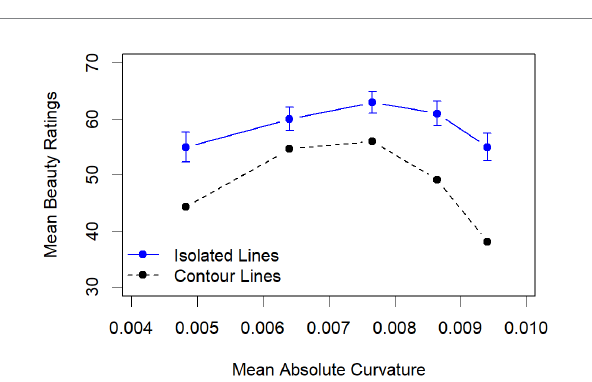
FIGURE 6 Mean beauty ratings of the isolated lines and mean beauty ratings of the contour lines across vase width as function of their mean absolute curvature. The error bars indicate the standard